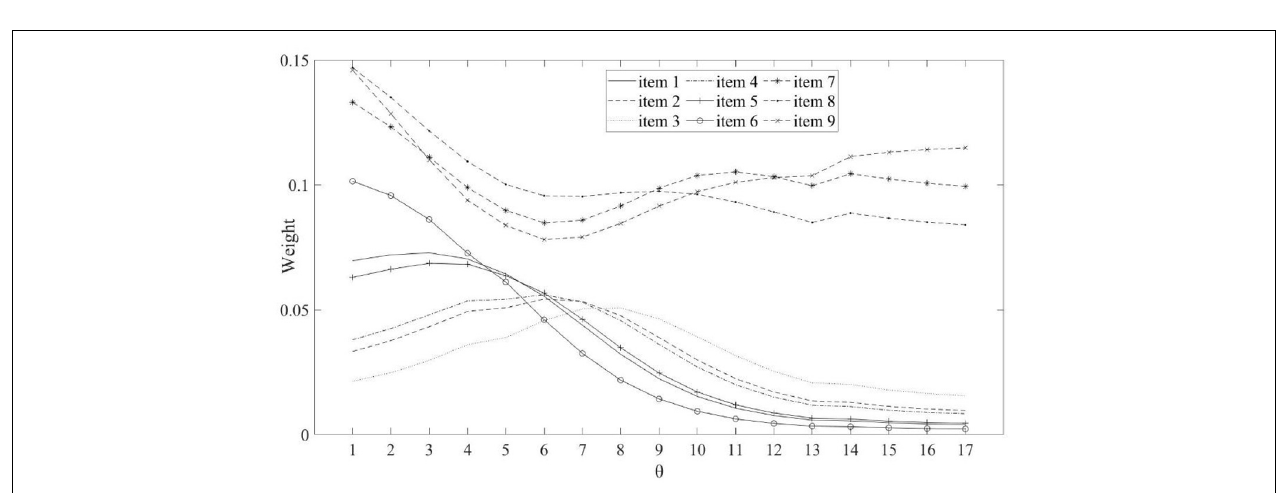
FIGURE 1 | The weights of IWLE based on θ 1 for dichotomous items (item 1 to 6) and polytomous items (items 7 to 9) in test 1.